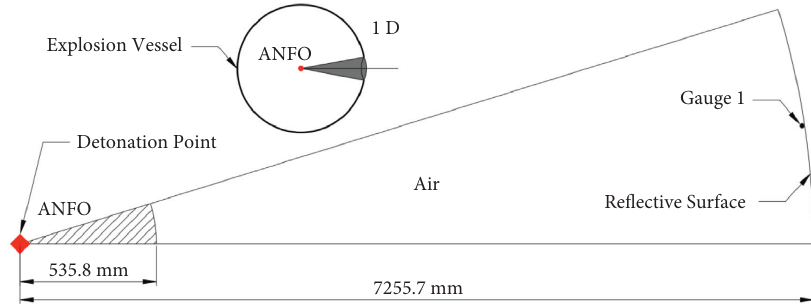
Figure 1: The calculation model of explosive load.